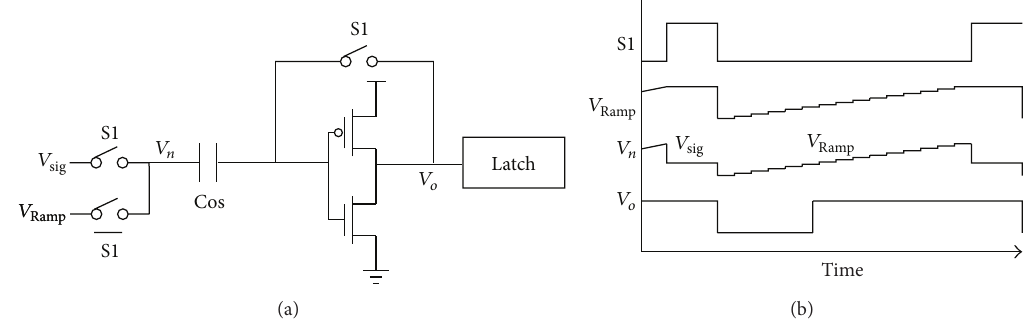
Figure 6: The schematic and operating timing sequence of the single slope ADC.